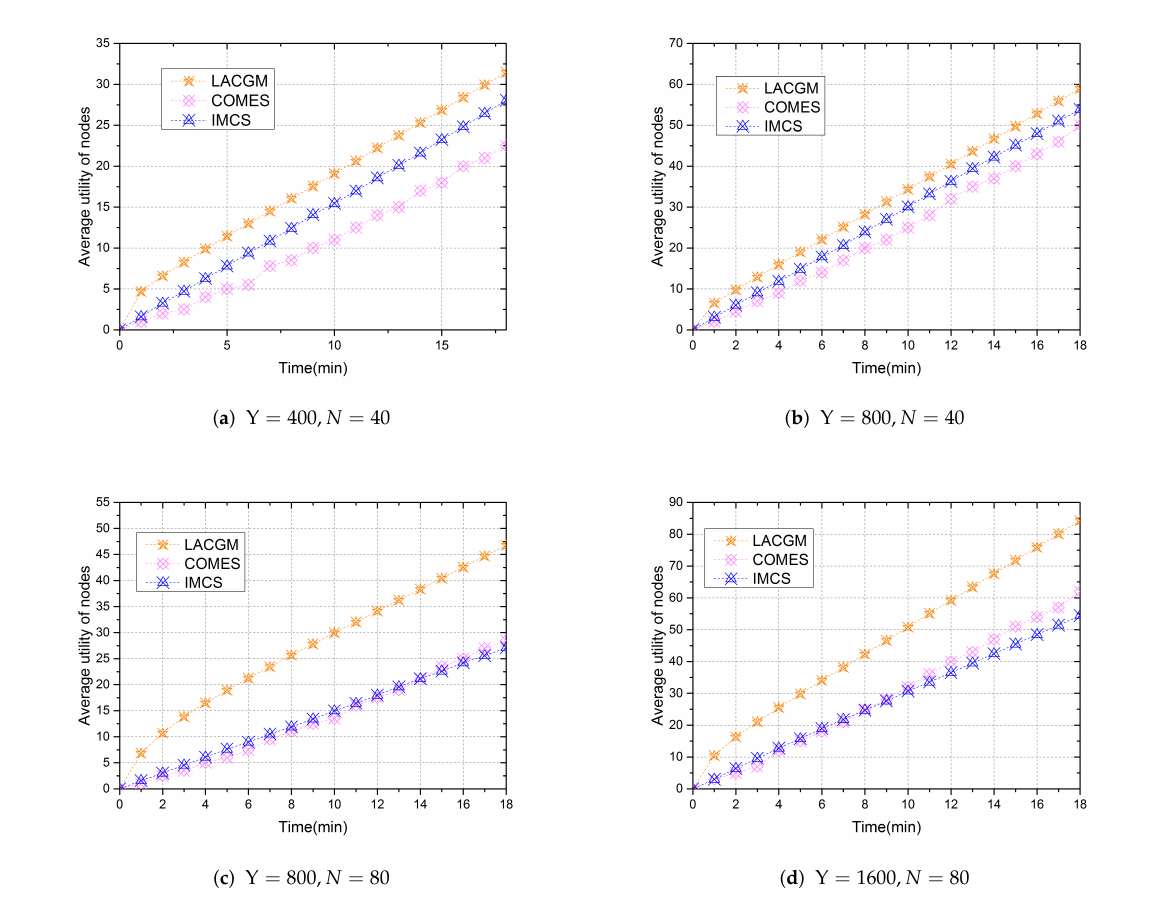
Figure 7. Average node utility changes with the number of messages and